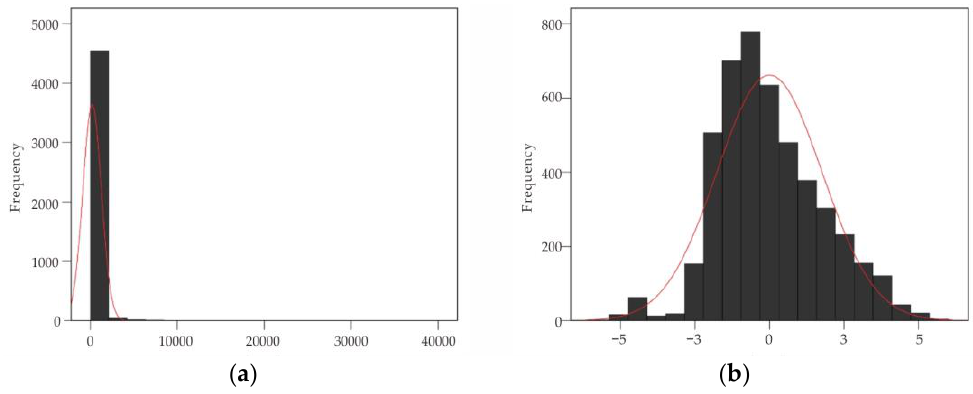
Figure 12. Histogram of Au. ( a ) Raw data. ( b ) clr-transformed data.